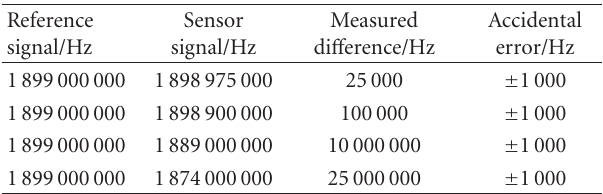
Table 1: Measurement results of sensor signal processing